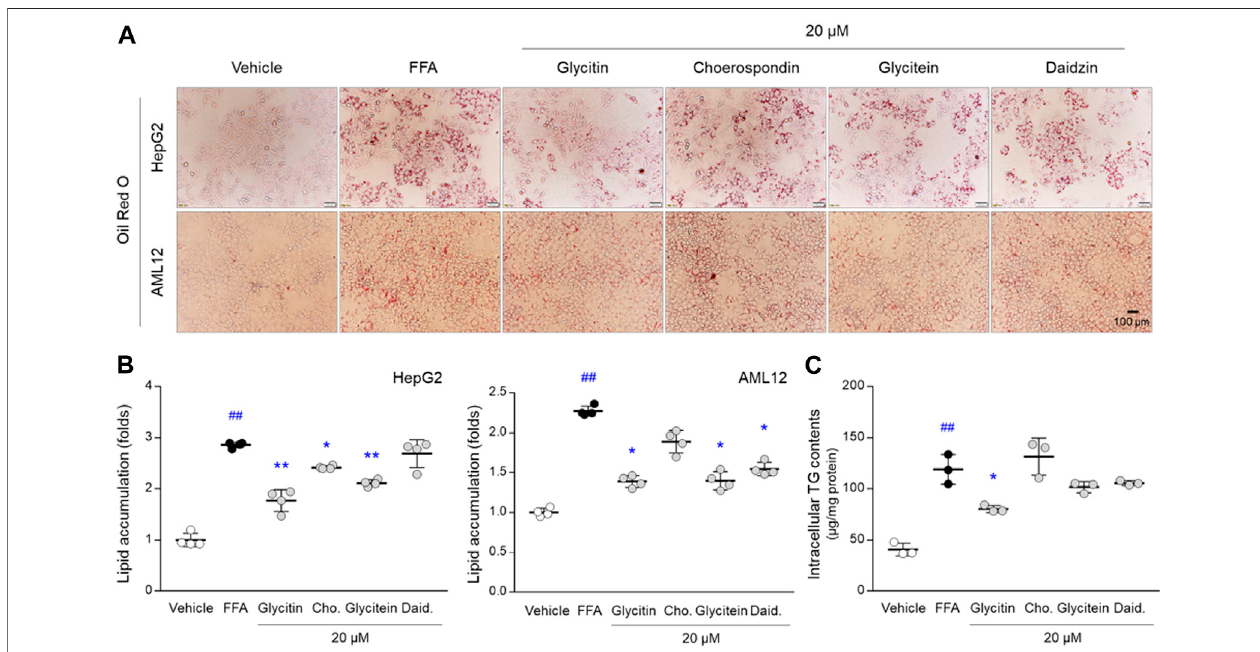
FIGURE 5 | Effects of four iso fl avones against NAFLD conditions in both HepG2 and AML12 cells. (A) Hepatic lipid accumulations and ROS productions were determined using Oil Red O staining and DCFH-DA assay, respectively. (B) Intracellular lipid accumulations in HepG2 and AML12 cells and (C) TG contents in HepG2 cells were quanti fi ed. Data areexpressed asthe mean ± SD( n =3 or4). ## p < 0.01compared tothe vehicle-treated cells, and p p < 0.05 and pp p < 0.01 compared tothe cells exposed to